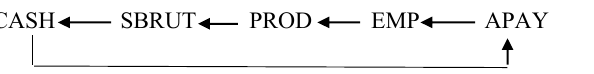
Figure 1. Closed cycle of relations between five endogenous variables in a small enterprise.